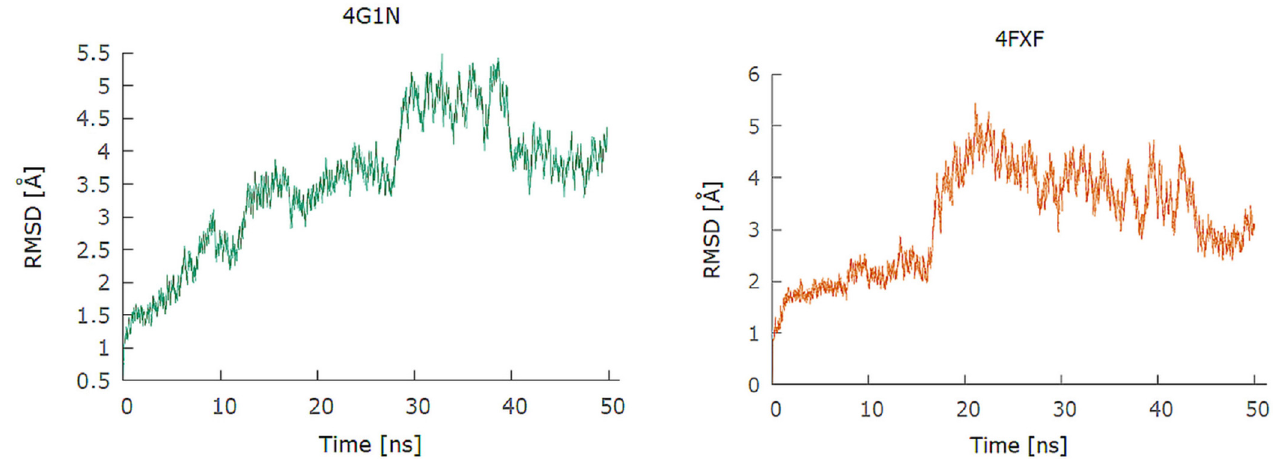
Figure 6. Root mean square deviation (RMSD) of the protein backbone atoms with respect to the equilibrated structure.